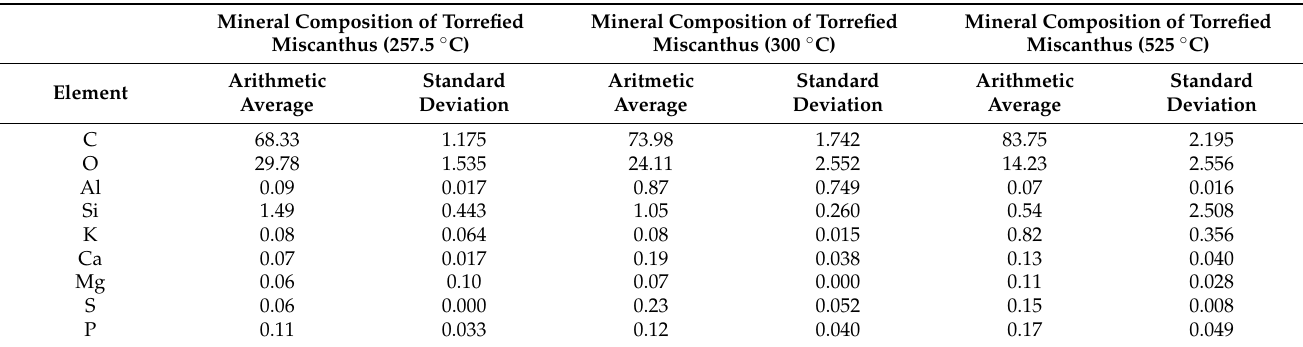
Table 5. Content of mineral elements in the torrefied Miscanthus and untreated Miscanthus at three different temperatures. Mineral Composition of Torrefied Miscanthus (257.5 ◦